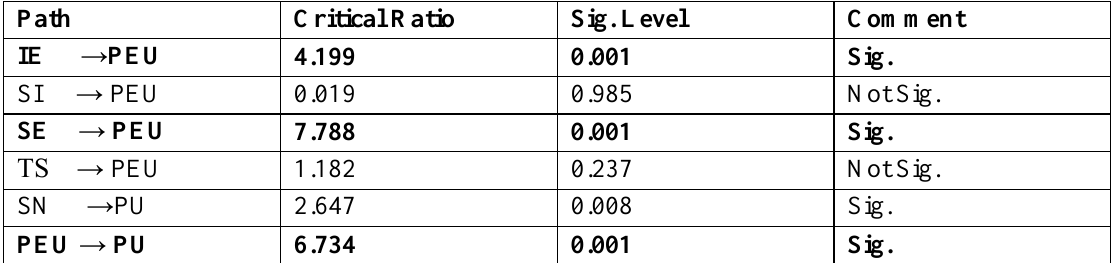
Results of Path